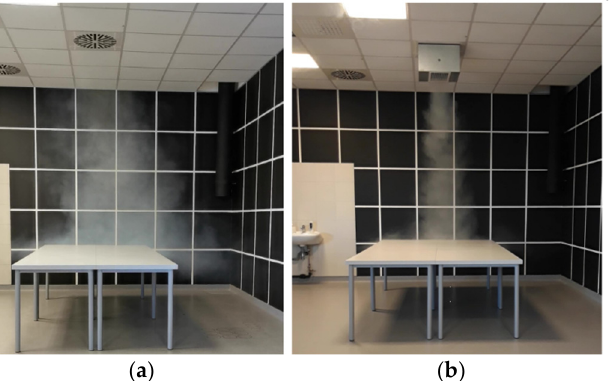
Figure 10. Air Flow pattern without ( a ) and with the air-jet control box ( b ) examined with the “Island of four” setup.